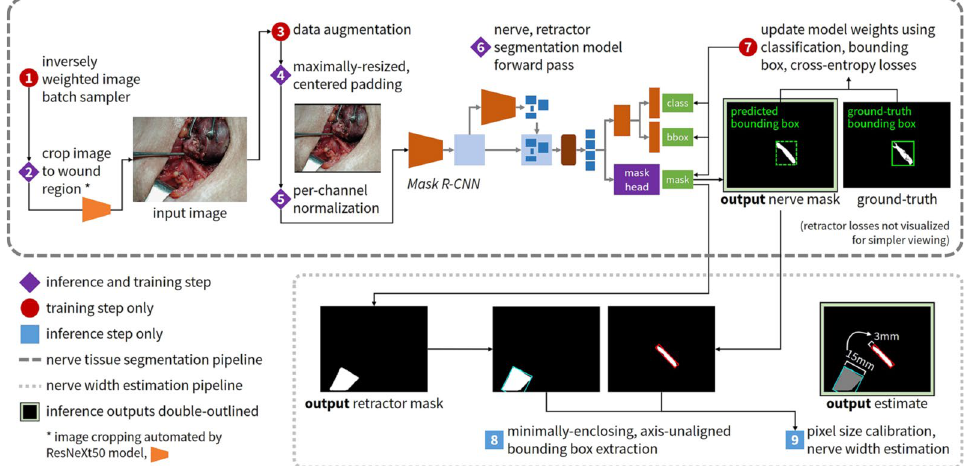
Figure 1. Illustration of end-to-end training and inference pipeline. Full training and inference pipeline of the proposed method for the joint nerve segmentation and measurement task. Best viewed in color. For nerve segmentation (upper half, in dark dashed box), during training, images are sampled inversely proportional to the frequency of that patient in the dataset. All images are automatically cropped using the trained bounding box predictor (where ground-truth bounding boxes for close-up images are the entire image, allowing the model to learn when and when not to crop; see Supplementary Fig. S1 for model details). Then, all images are augmented randomly via geometric and stylistic augmentation. They undergo maximally-resized, centered padding. Images are then normalized using the training dataset mean and standard deviation and run through the model to obtain the output segmentation mask. For training, the ground-truth tight, axis- aligned instance bounding box is automatically computed to minimally enclose the nerve segmentation. The output segmentation mask and ground-truth image, along with the predicted and ground-truth segmentation bounding boxes and class label (nerve), are used to compute the multi-task training loss function. The loss is back-propagated through the network to update the model weights. In inference, test images are cropped, padded, resized, and normalized as done in training, and the resulting images are passed through the model for the output segmentation. The mask prediction with the highest score is taken to be the final prediction. Next, for maximum nerve width estimation (lower half, in light dotted box), we use the same training pipeline and data preprocessing methods for the army-navy retractor segmentation model, using ground-truth retractor segmentations. The loss is the same multi-task loss function used to train the nerve segmentation model. All retractor predictions with greater than 0.5 confidence are kept. During inference, the nerve and retractor segmentations are obtained after the respective models’ forward passes. The minimally-enclosing, axis- unaligned bounding box for each segmentation is obtained. The army-navy real-world measurement of 15 mm is used along with the bounding box of the retractor to calibrate the pixel-to-millimeter ratio, which is then used to calculate the final nerve